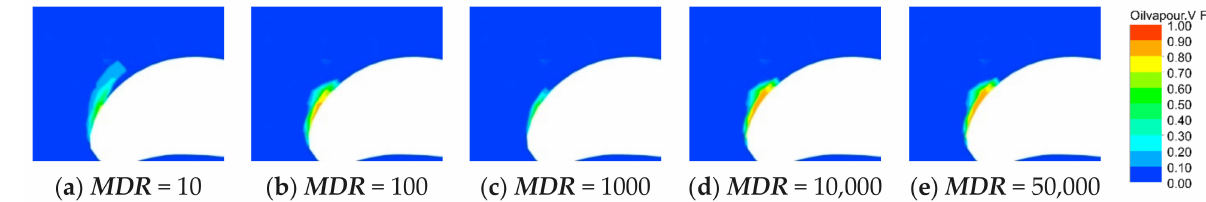
Figure 36. Oil vapor volume fraction distribution in stator domain at stall under various maximum density ratios.